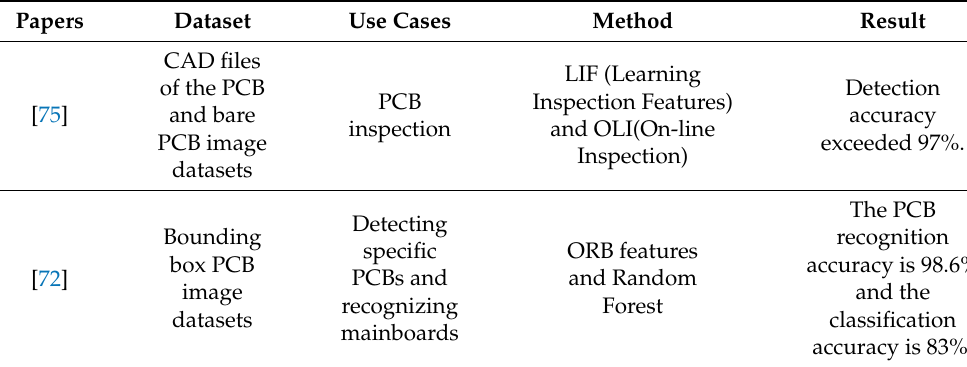
Table 5. Comparative analysis between existing works and our